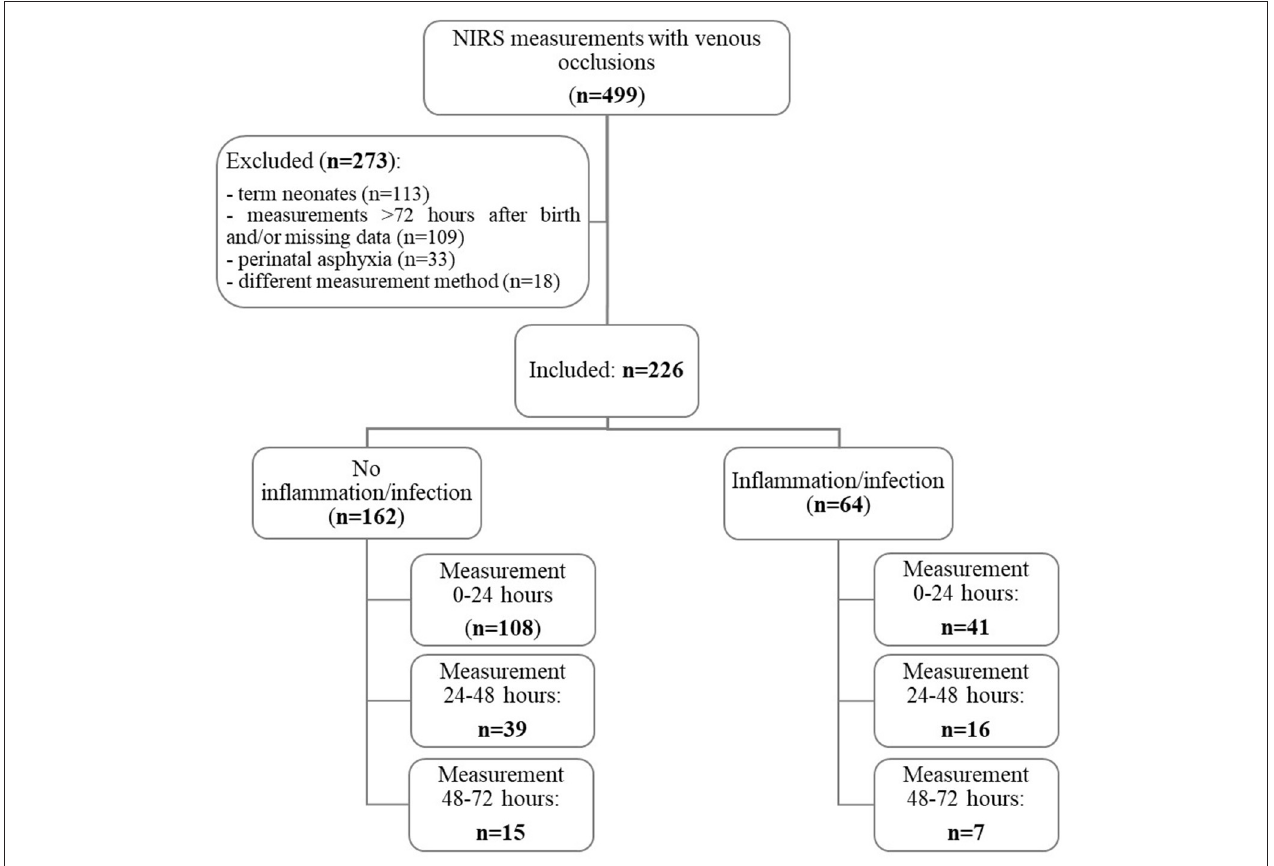
FIGURE 1 | Patient flow